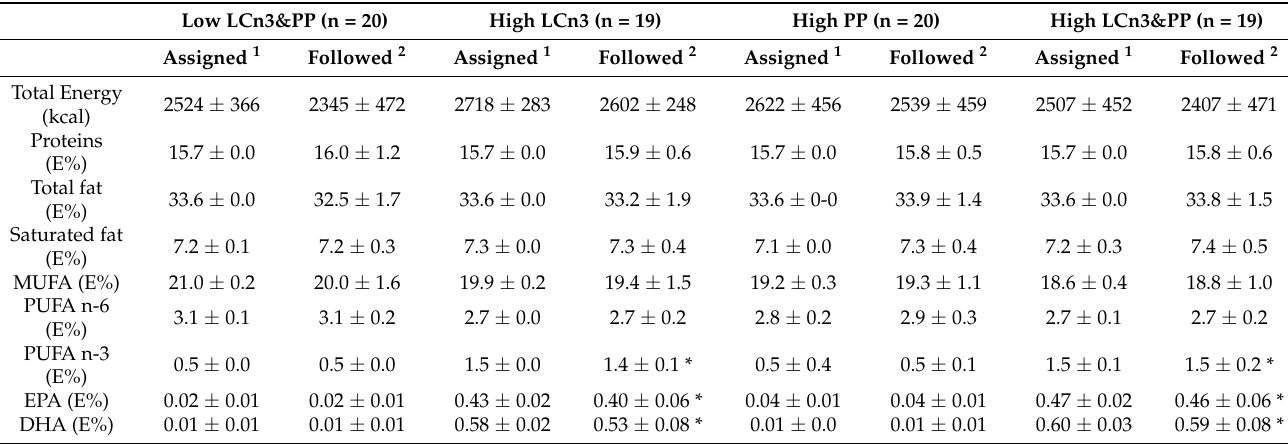
Table 1. Mean composition of the diets assigned per protocol and the diets followed in the four groups of participants in the dietary intervention